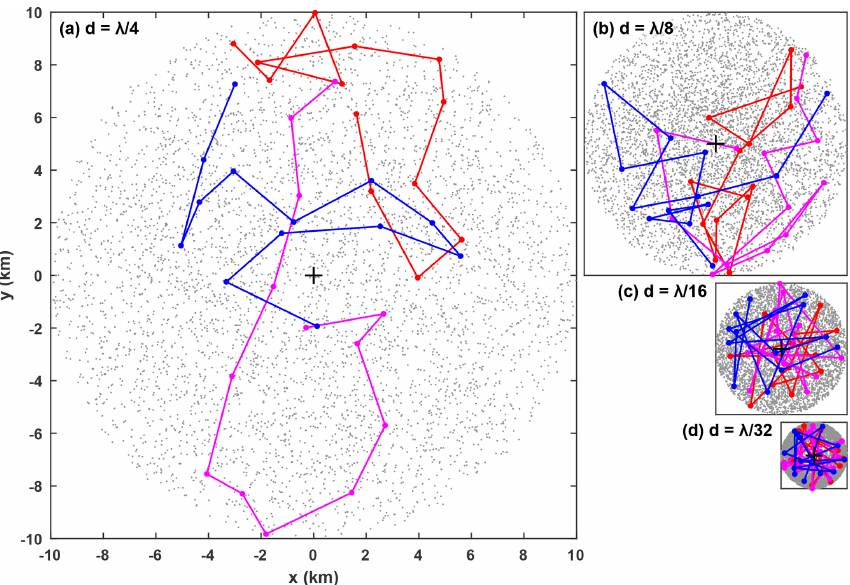
Figure 6. Pseudorandomly distributed glider paths within watch circles of diameters (a) 1 / 4 λ , (b) 1 / 8 λ , (c) 1 / 16 λ , and (d) 1 / 32 λ . The first 5000 surface locations are shown with a grey dot and the first three twelve-dive scenarios are shown in colour. The black cross is the location of the ADCP at the centre of the watch circle. All four panels are the same